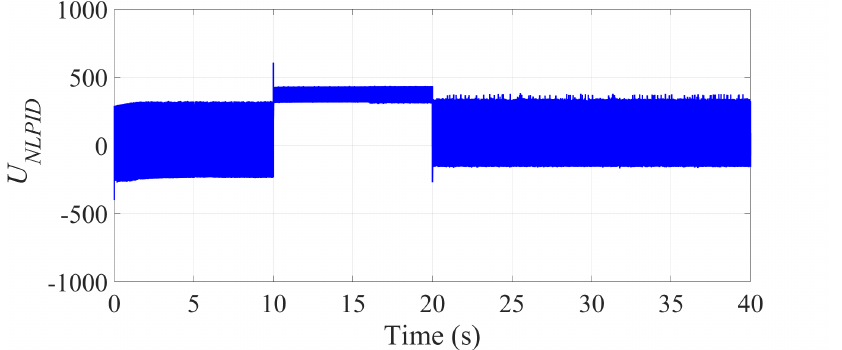
Figure 17. Scenario 2: Control input to generate the duty cycle of a PWM signal using the proposed nonlinear PID controller.